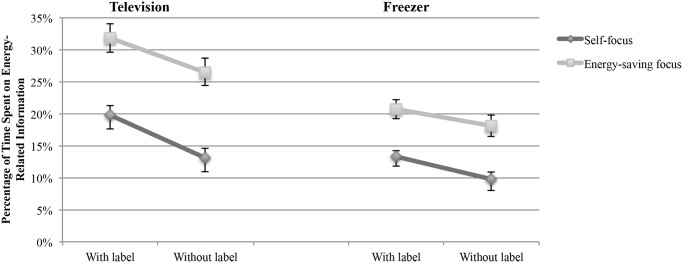
Percentage of decision time spent on energy-related information as a function of label (with vs. without label) and focus (self vs. energy saving).The error bars represent the standard error.